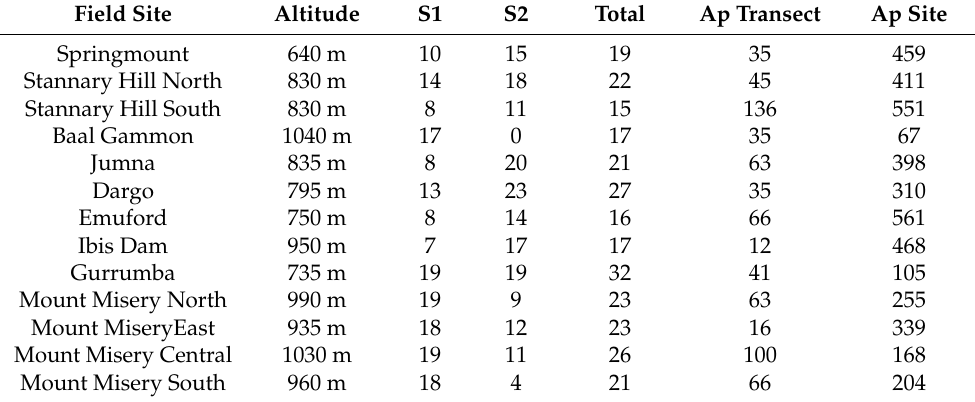
Table A1. Species diversity across two substrata (taller shrub layer, S1 and lower shrub layer, S2) and the species count for A. purpureopetala across each transect (Ap Transect) and across the field site (Ap site). Field sites appear in the order of numbering on the map in Figure